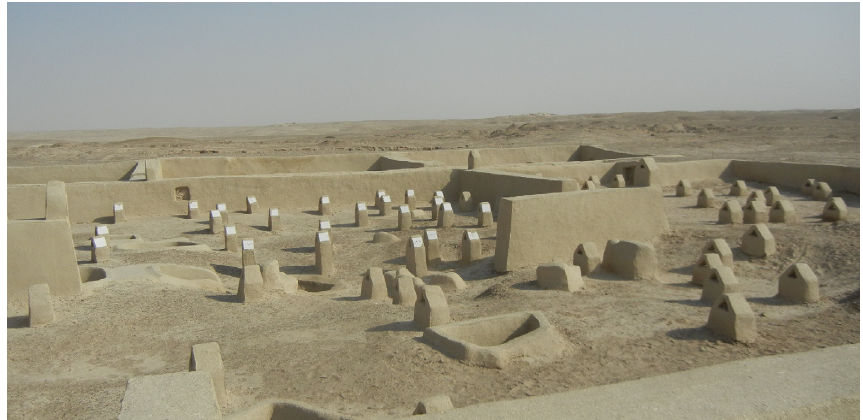
Figure 1. A part of the necropolis in Shahr-e Sukhteh archeological site.